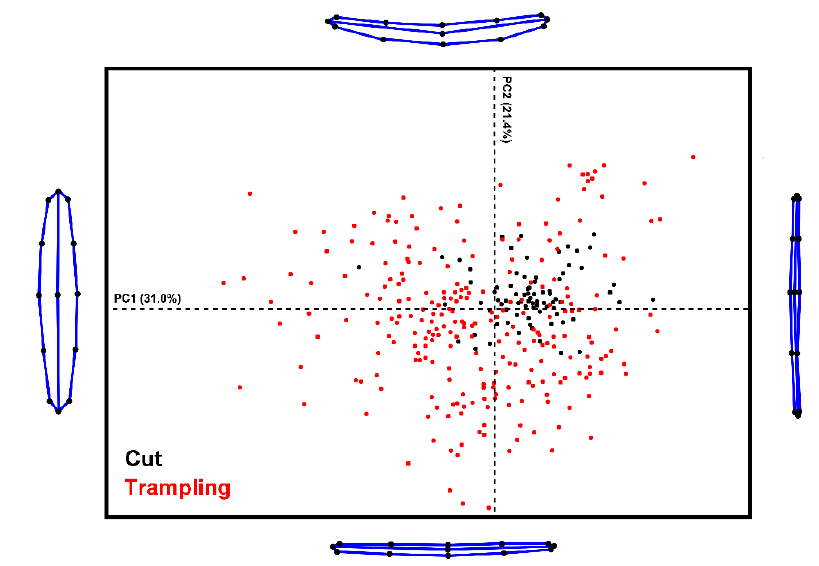
Figure 3. Principal Components Analysis comparing Cut and Trampling Mark morphologies. Extreme shape changes can be observed at the extremity of each PC score.